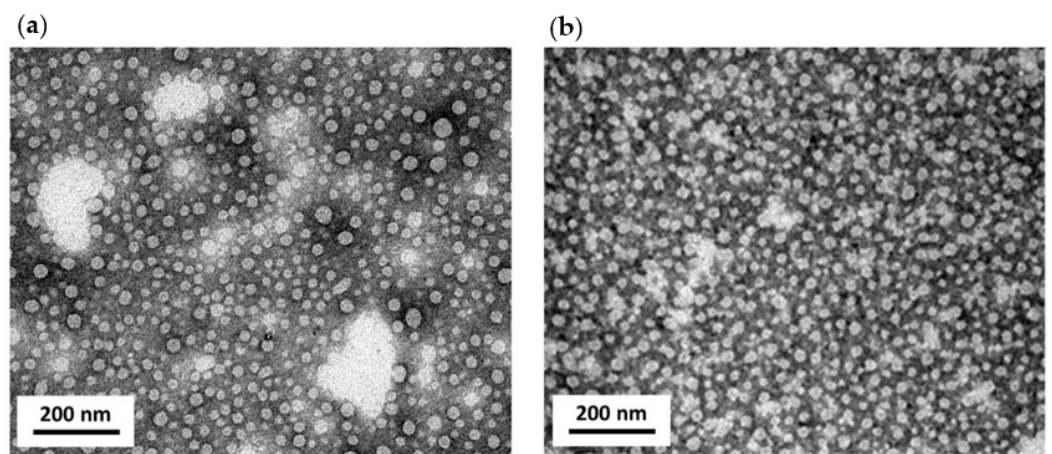
Figure 3. Transmission electron micrographs of nanoparticles assembled by p116. ( a ) a TEM image of particles assembled by p116 alone. ( b ) a TEM image of particles assembled by p116 added with the fluorescent molecule FITC during the particle formation process. The TEM imaging was conducted with electrons with an energy of 100 KeV. The scale bar in each image represents 200 nm. According to TEM imaging, the protein is able to assemble into nanosized particles with or without interacting with the anionic molecules.